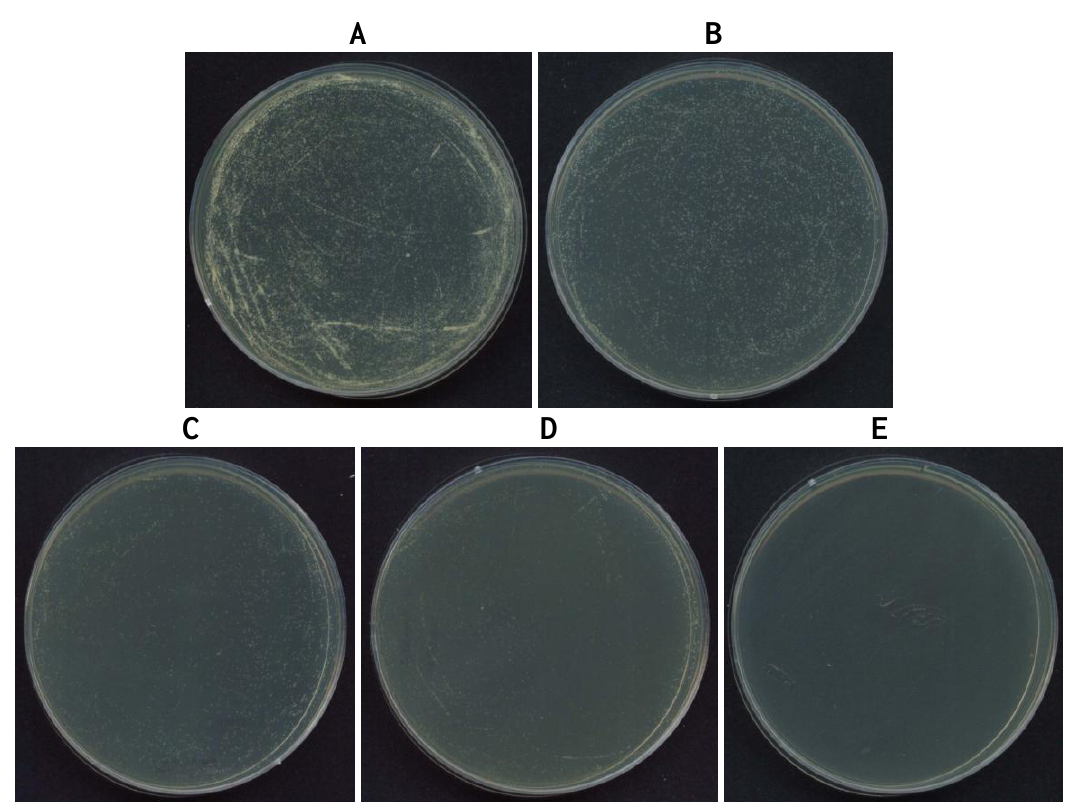
Figure 5. Antifungal activity of synthetic potide-J peptide aganist C. albicans . A : not treated with peptide, B : 7.5 μg/mL, C : 15 μg/mL, D : 30 μg/mL, E : 60